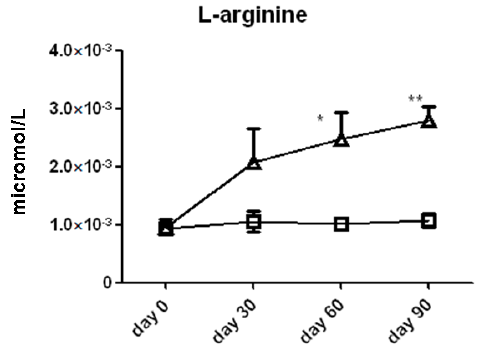
Figure 3. L -Arginine content per 100 µL of serum in subjects treated with L -arginine (triangles) or placebo (squares). Data are presented as mean ± SEM. * denotes p < 0.05 and ** denotes p < 0.01.